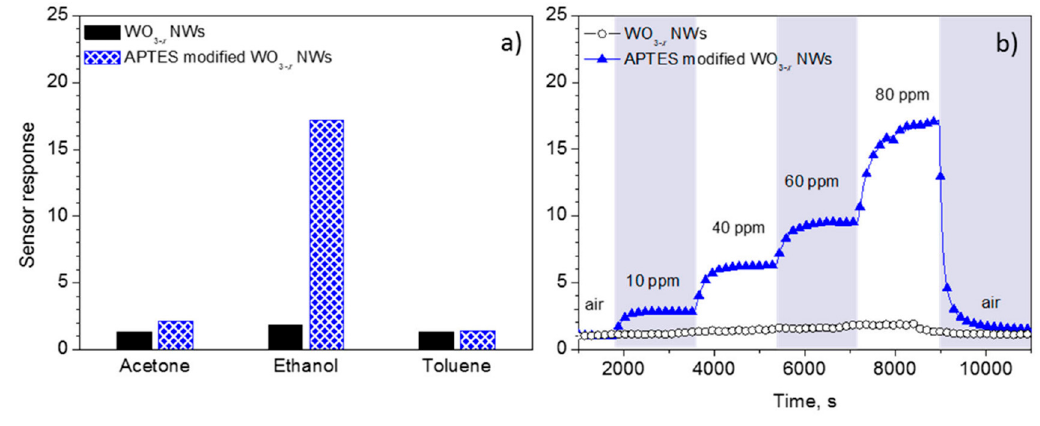
Figure 3. Sensor response to 80 ppm of acetone, ethanol and toluene ( a ), and sensor response towards various concentrations of ethanol ( b ) for the APTES modified and non-modified WO 3-x